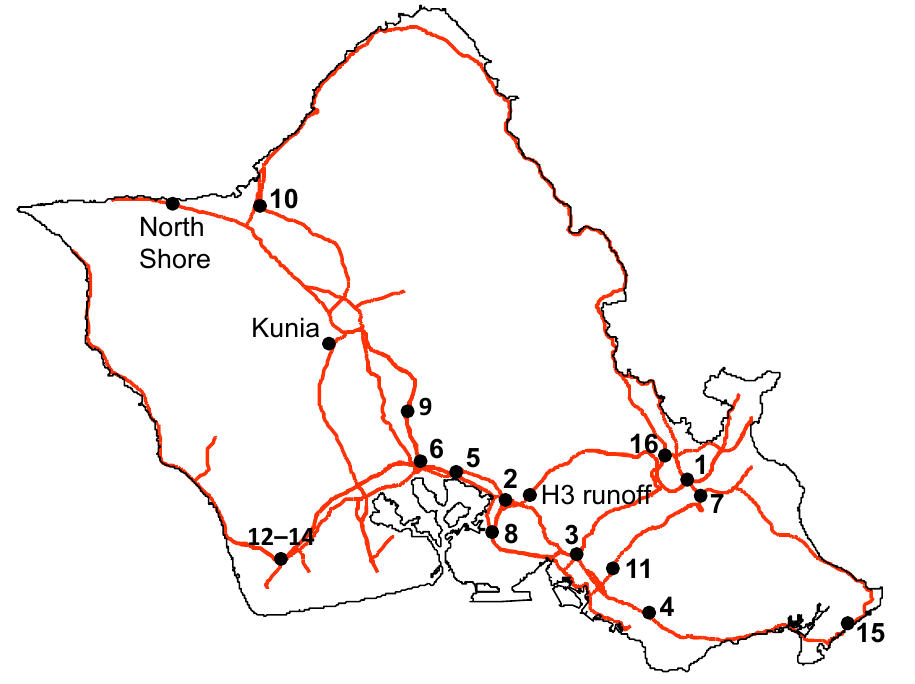
Figure 1. Selection of sampling sites for potential siting of infiltration trenches along highways and